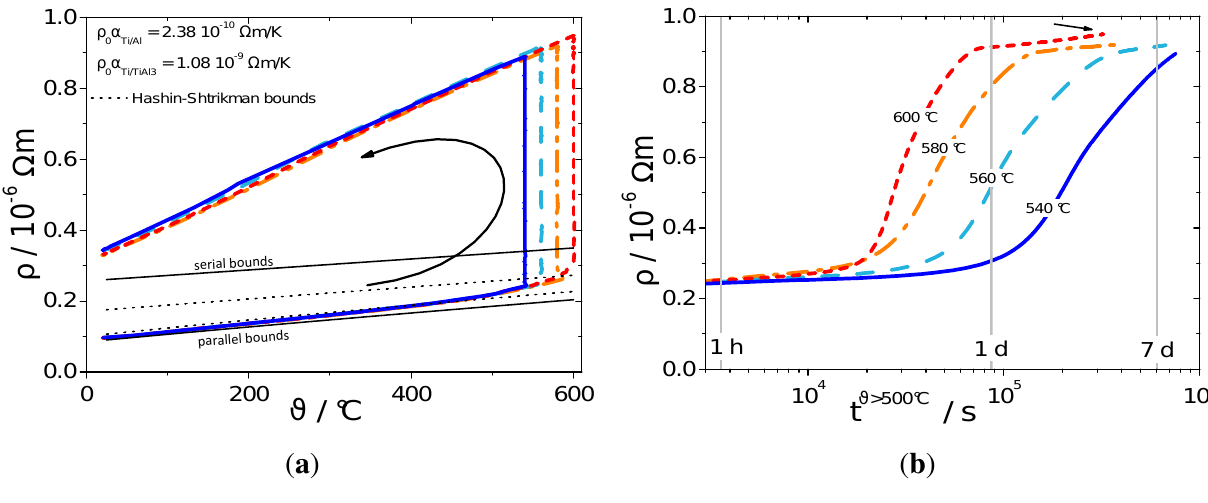
Figure 5. Resistivity measurements of the wires during isothermal heat treatments at different temperatures. ( a ) Electrical resistivity vs . temperature; ( b ) same data as shown in ( a ) but plotted vs .